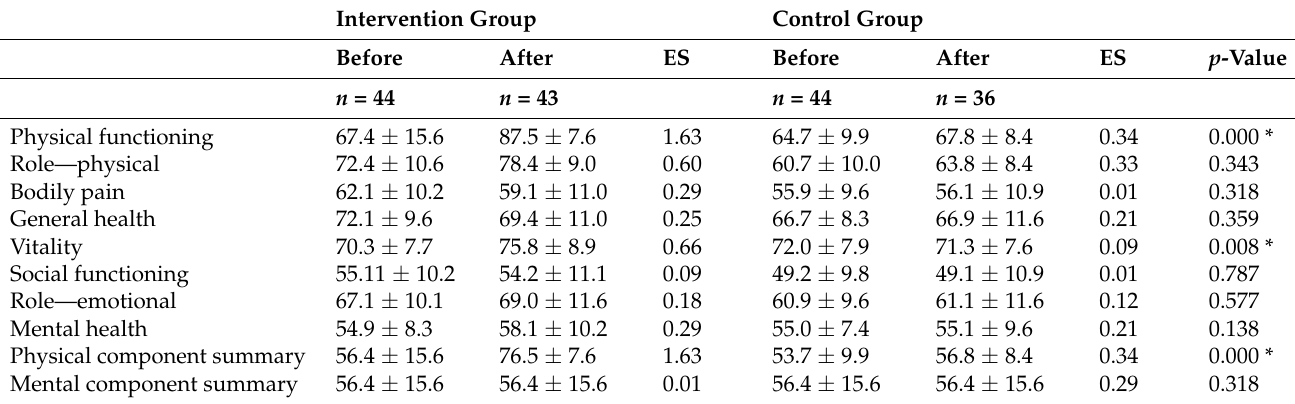
Table 3. Effect of physical activity on quality of